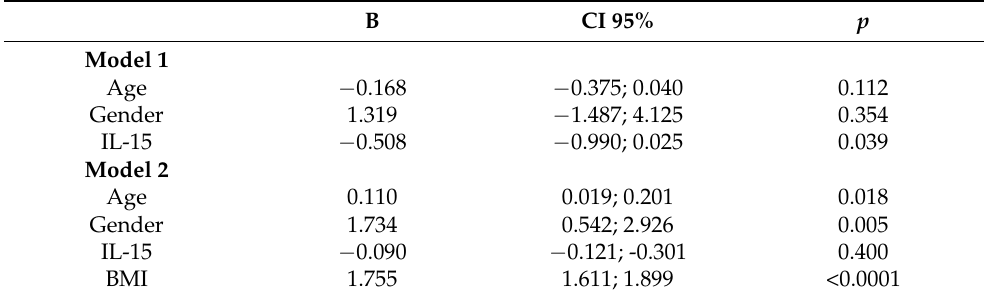
Table 2. Linear regression analyses exploring the association of IL15 with METS-IR, controlling for multiple confounding factors in the studied population ( n = 132). B CI 95% Model 1